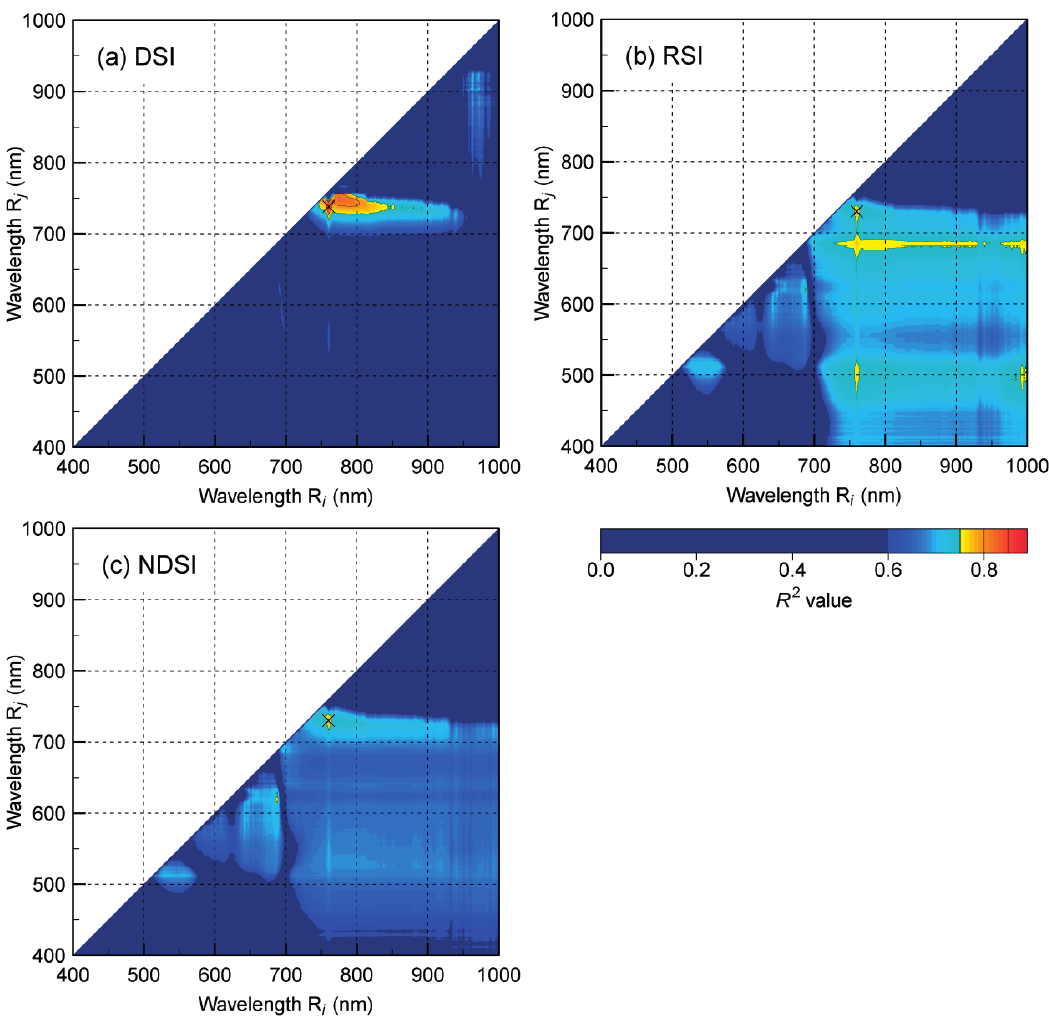
Figure 2. Contour maps of the coefficient of determination ( R 2 ) between LAI and ( a ) DSI; ( b ) RSI; and ( c ) NDSI. The crosses (x) indicate the points with the highest R 2